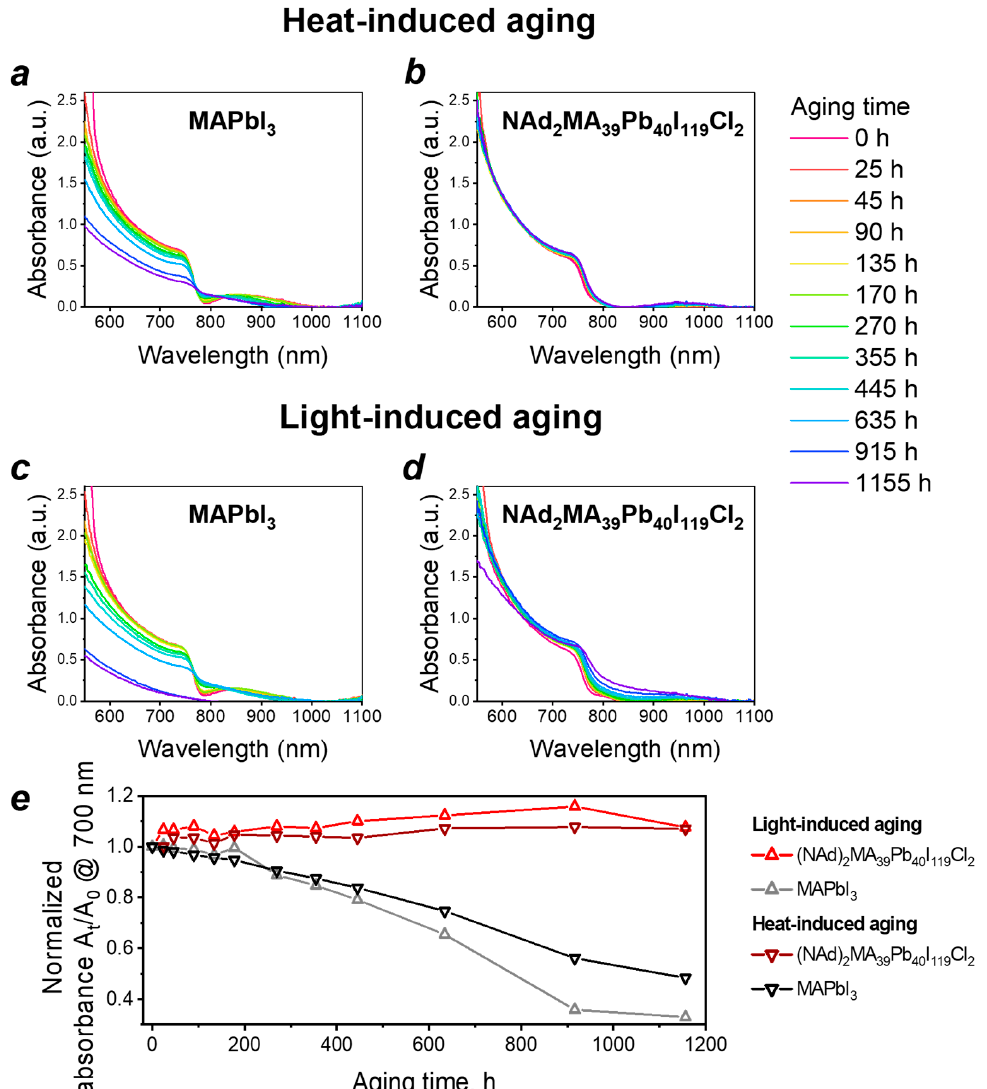
Figure 2. The behavior of the UV–vis spectra of ( a , c ) MAPbI 3 and ( b , d ) NAd 2 MA 39 Pb 40 I 119 Cl 2 films in the course of ( a , b ) heat-induced and ( c , d ) light-induced aging. ( e ) The comparison of the degradation dynamics of the samples is based on the evolution of the relative absorbance of the films (A t /A 0 ) at 700 nm as a function of the aging time t.